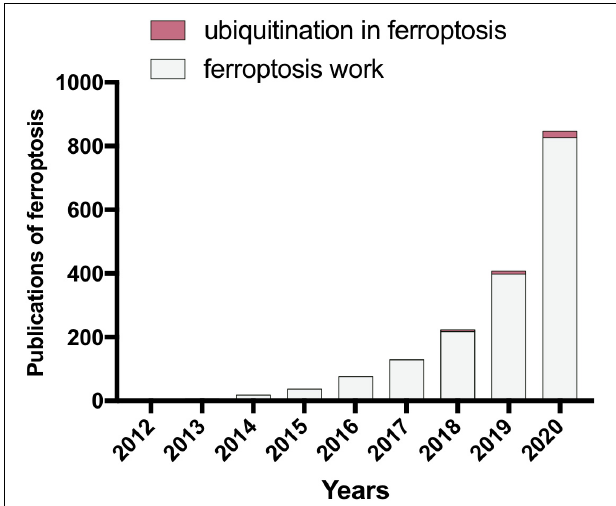
FIGURE 1 | The publications of ferroptosis study in the last decade (PubMed). Since 2012, the contributions of ferroptosis research have been dramatically increased throughout the world. The importance of ubiquitination has been gradually uncovered in the area of ferroptosis research. However, further studies are still required to elucidate more details of the connection between ubiquitination and